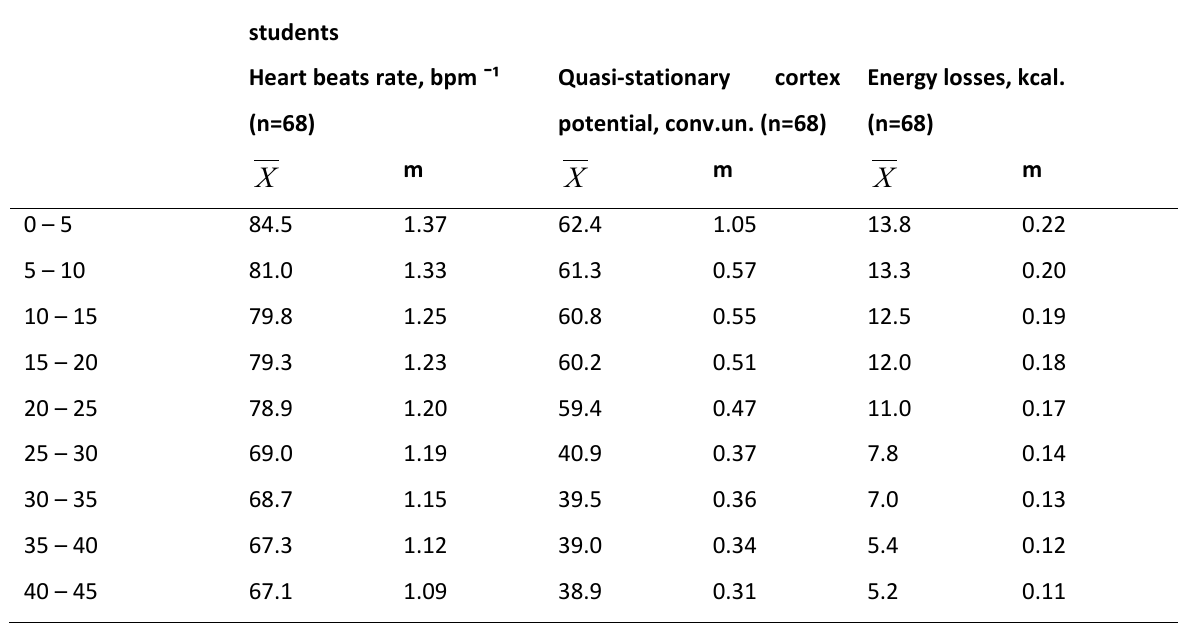
Table 2. Characteristics of heart beats rate, quasi-stationary cortex potential and energy losses of 2 nd year girl students, registered during mastering multimedia manual’s material Time periods,